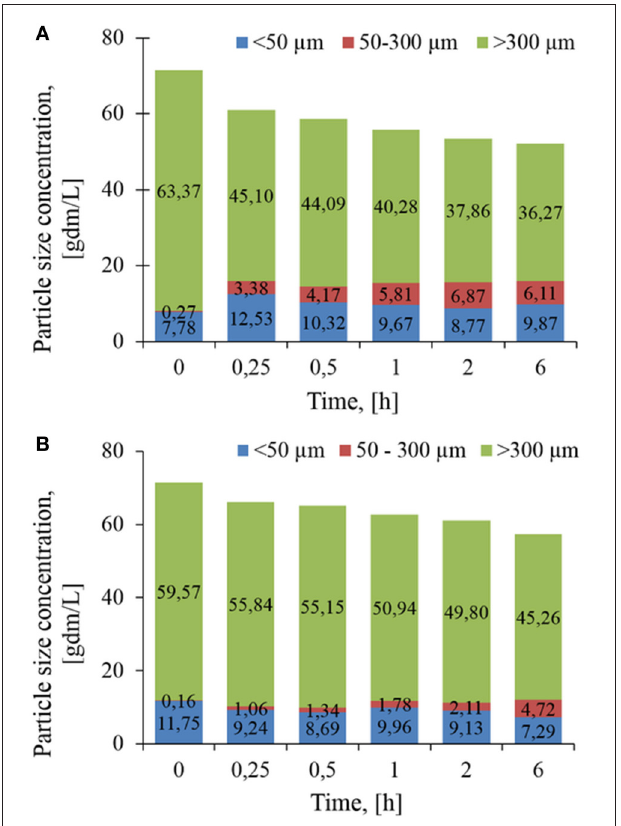
FIGURE 4 | Evolution in the abundance of population class as determined by their chord length, lc during the treatment of the wheat bran suspension by Rovabio ® (A) and xylanase C (B) . Chord length distribution, En(lc) was mulitplied by the total number of counted particles per sec (Nc). Operating conditions identical to Figure 2 .